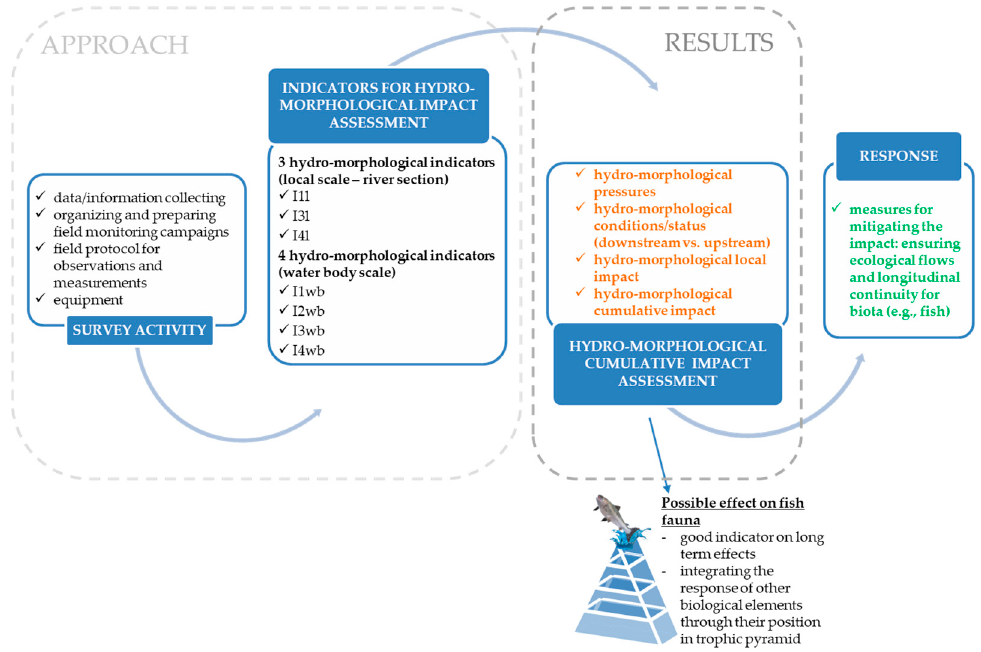
Figure 5. Diagram for the process of the cumulative hydromorphological impact assessment approach following the DPSIR analytical framework—waterworks in place .